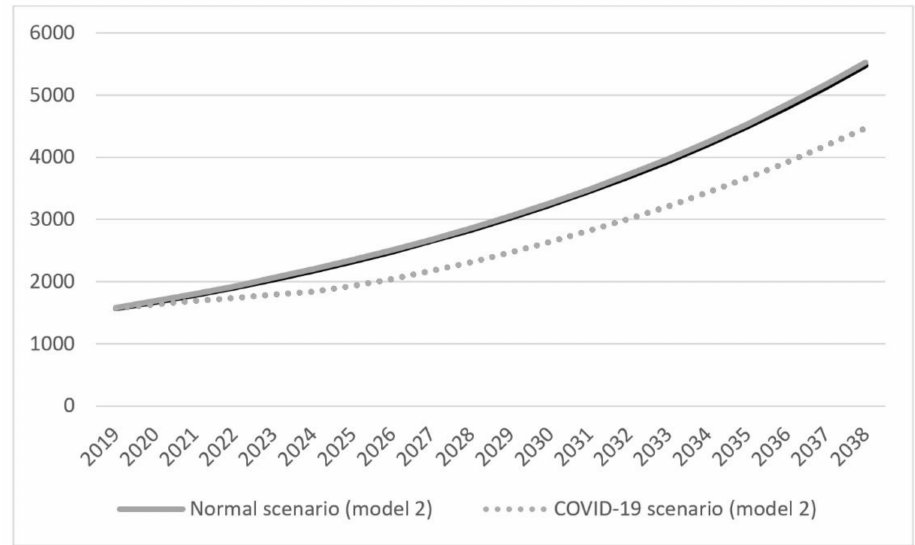
Figure 7. Forecast total energy demand for model 2 (petajoules). Note: We calculated the ex ante errors (i.e., upper and lower limits of confidence interval) for the for the forecast total energy demand under the business-as-usual scenario. In percentage terms, the maximum deviation was consistent and ranged within 5.0 to 5.1% for the upper level and − 5.1 to − 5.0% for the lower level. The trend graphs are presented in Appendix A Figure A2.